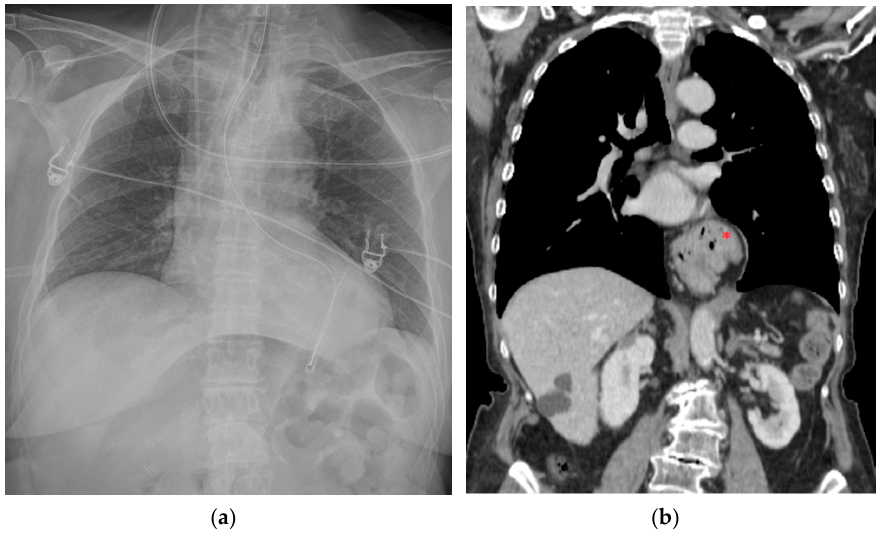
Figure 26. CXR of NG tube kinking shortly beneath the diaphragm, its tip projectively ending against the cardiac shadow ( a ); a right jugular CVC is also present. In the coronal view of the thoraco-abdominal CT scan of the same patient (before the NG tube was positioned) ( b ), it is possible to appreciate a hiatal hernia (red asterisk), which explicates the previous finding. Insertion into the respiratory tree (Figure 27) (tip in the trachea/mainstem bronchus/lobar bronchus) can lead to subsequent aspiration pneumonia [37]. cavity, and signs of perforation (i.e., subdiaphragmatic free gas) are noticeable [19]. Intracranial insertion of the NG tube is rare, mostly reported in cases of skull base trauma or surgery (Table 5)